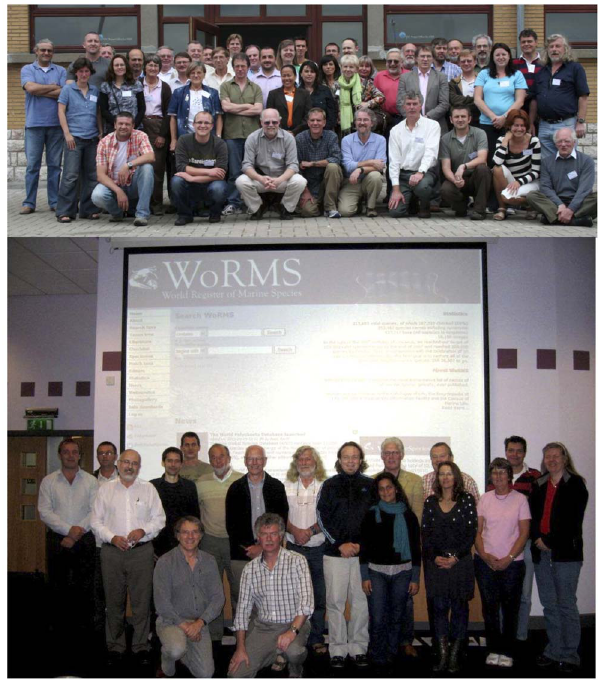
Figure 1. Some of the WoRMS editors at workshops in Ostend in 2008 (upper panel) and Aberdeen in